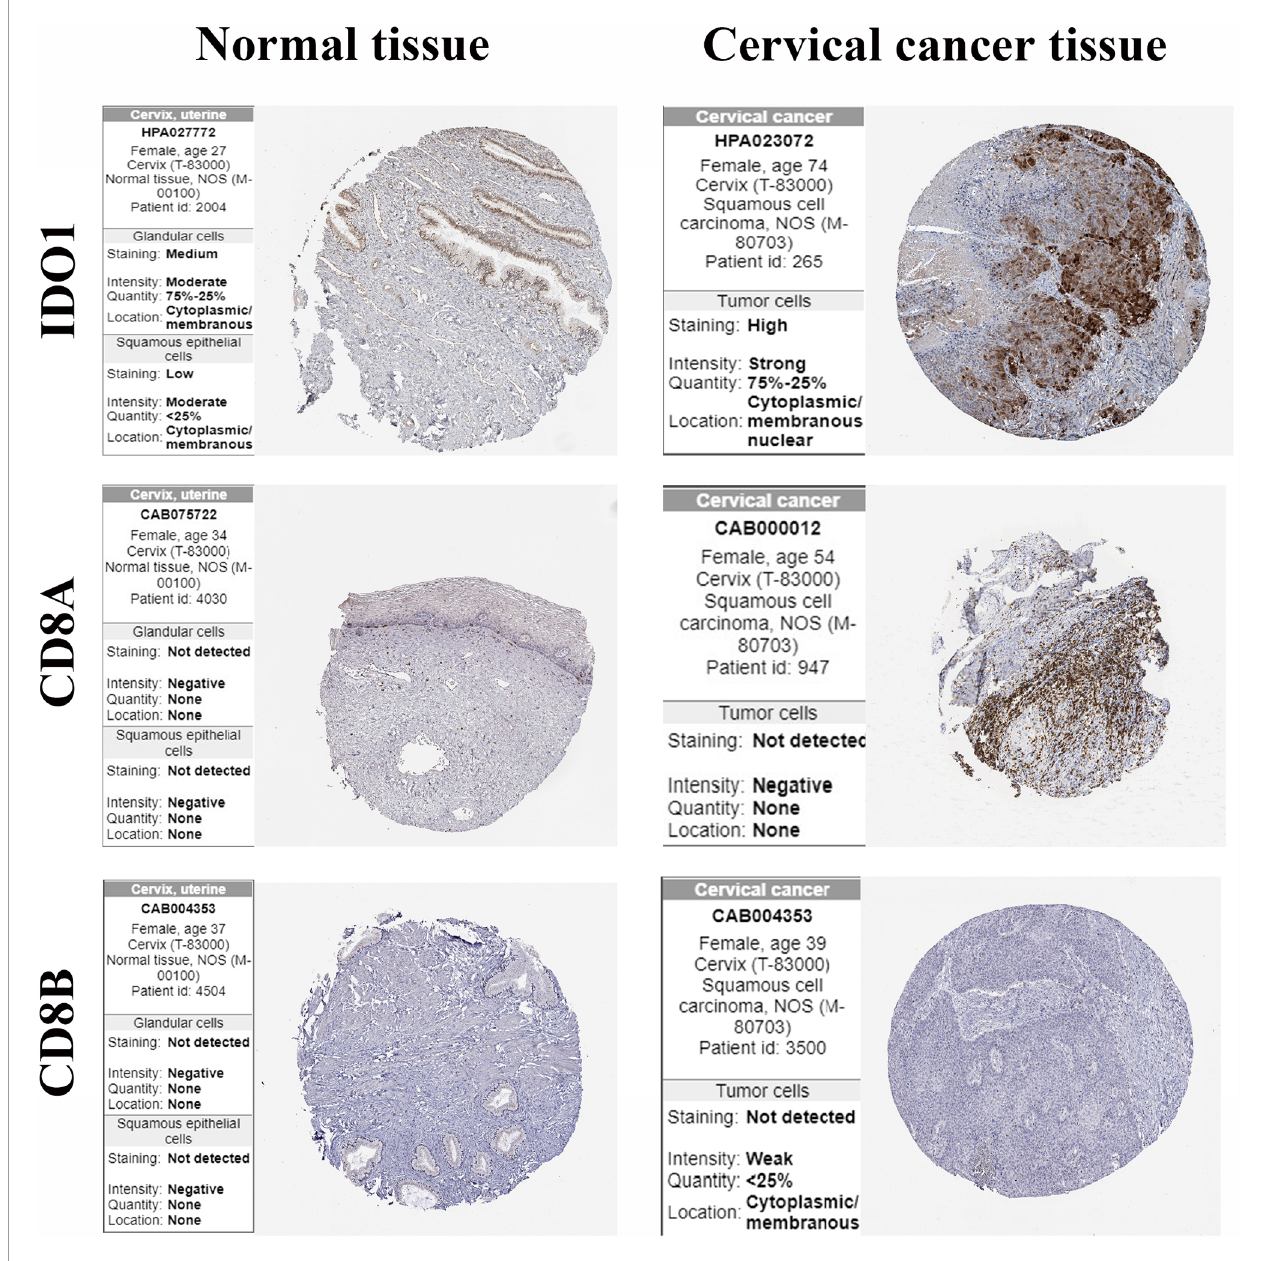
FIGURE 7 | Protein expression of IDO1 and gene markers in cervical cancer tissue and normal